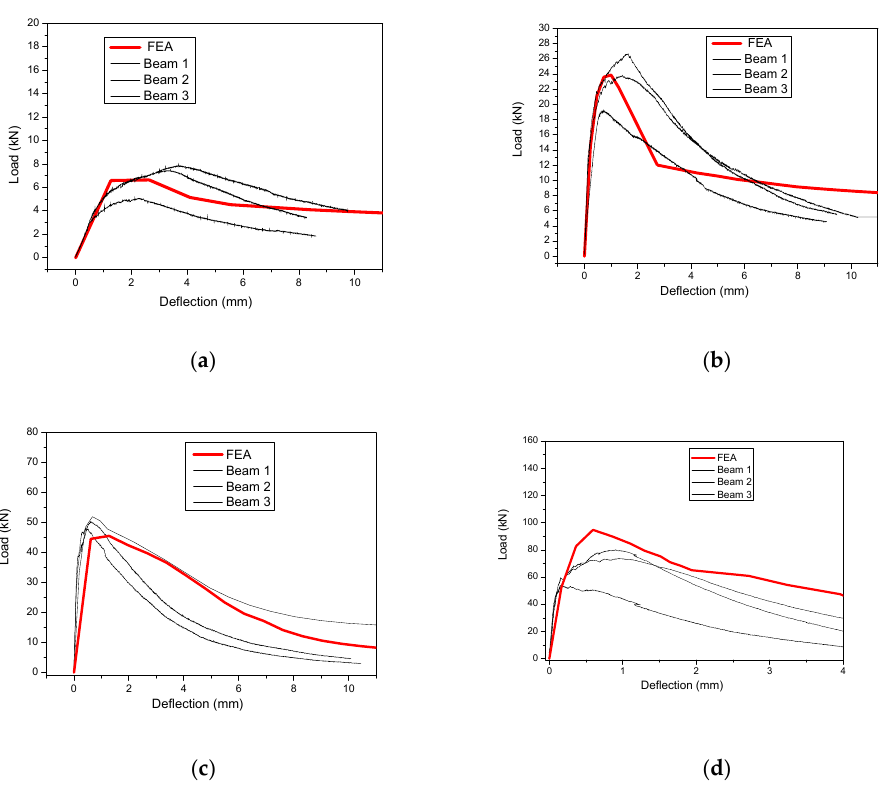
Figure 14. Load deflection results: Numerical vs. Experimental for UHPFRC-2 prisms with ( a ) 25 mm, ( b ) 50 mm, ( c ) 75 mm and ( d ) 100 mm depth values.